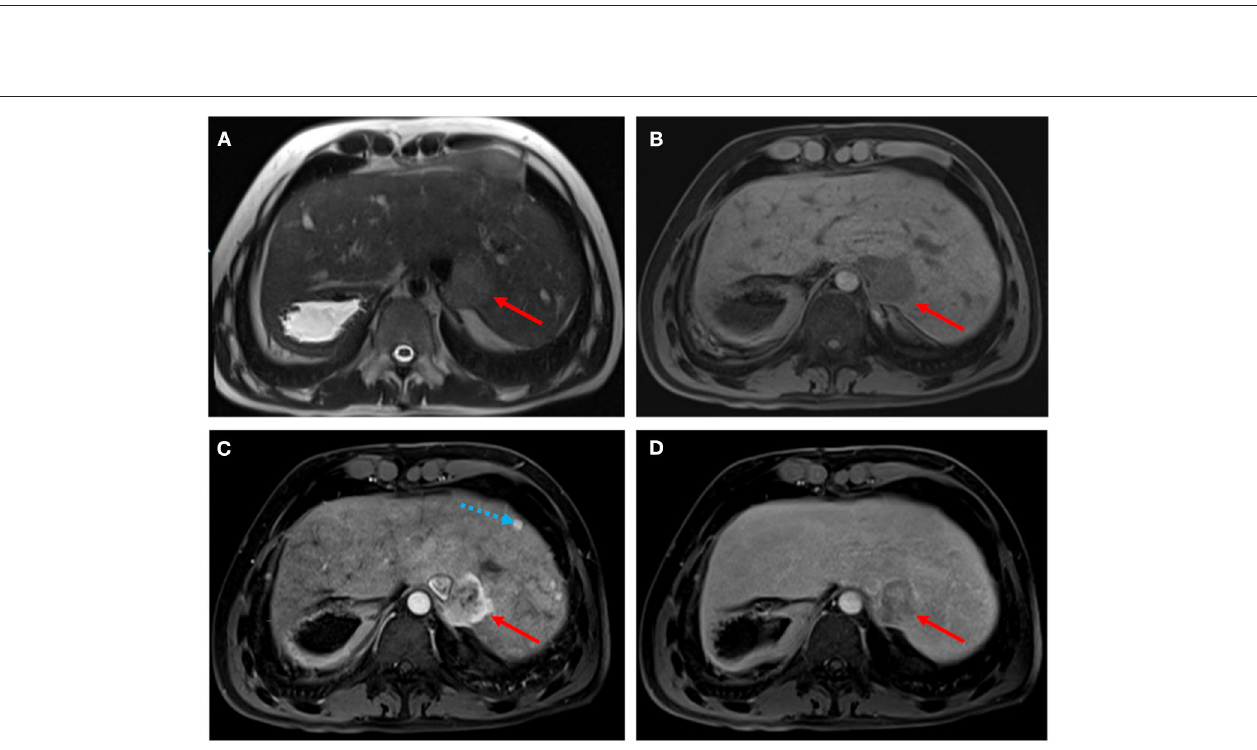
FIGURE 4 | Hepatocellular carcinoma in a 30-year-old man with Fontan palliation. Axial T2- and T1-weighted MR images (A,B) show a 4cm paracaval solid lesion with smooth margins and posterior hepatic capsule bulge (arrows). The tumor shows heterogeneous hyperintensity in the arterial phase of the dynamic contrast-enhanced sequence (C) , and typical washout in the delayed phase (D) . The background liver is diffusely heterogeneous after contrast injection, with multiple small arterial-enhancing foci [dotted blue arrow in (C) ] without delayed washout, in keeping with hypervascular regenerative hepatic nodules.